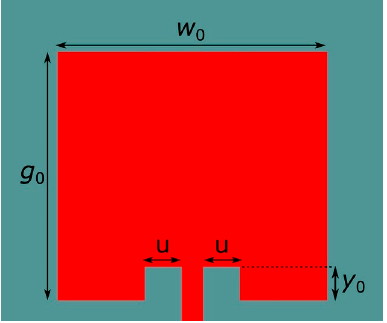
Figure 10. Ordinary patch antenna parameters.